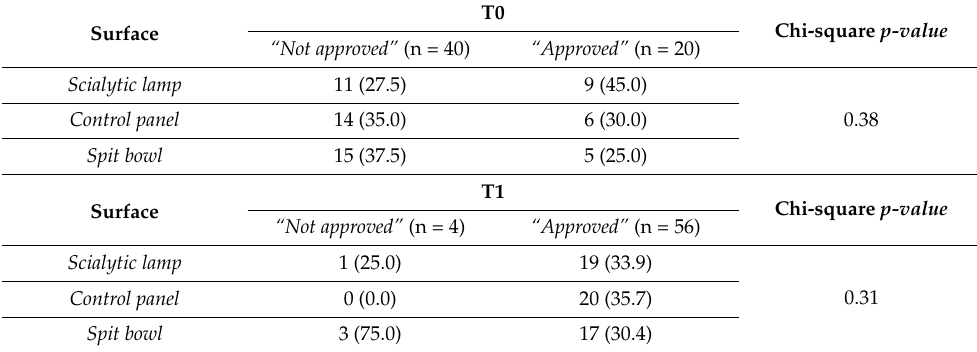
Table 6. Associations between the surface type and categorical disinfection results; ( p <